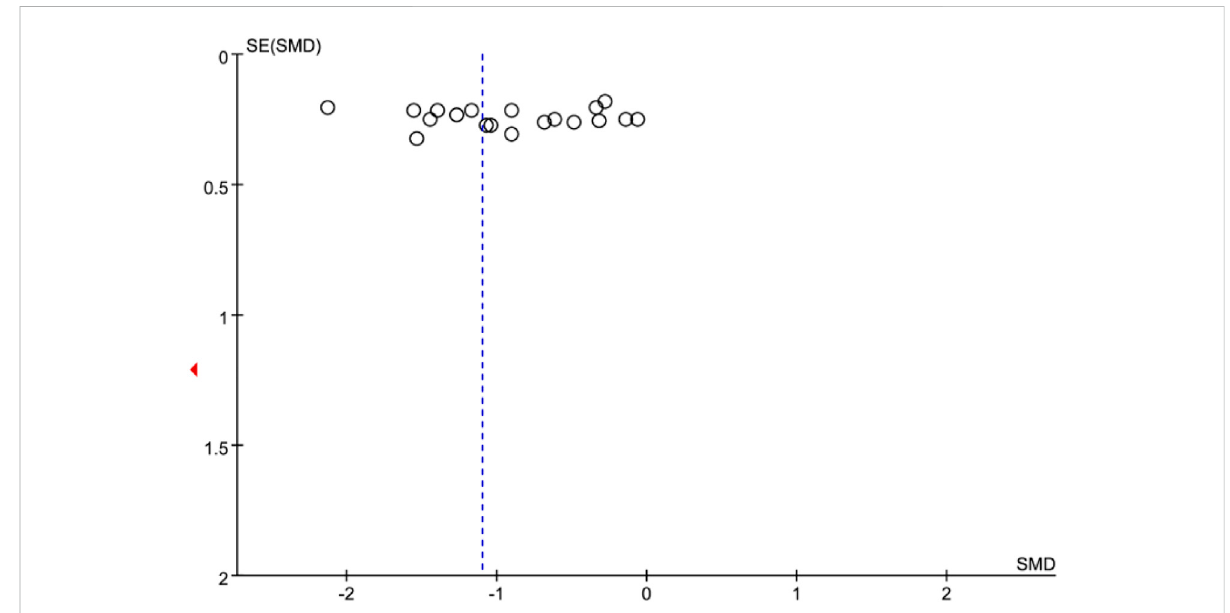
FIGURE 3 Funnel plot for meta-analysis of the effect of TCM combined with Western medicine on 24-h urinary